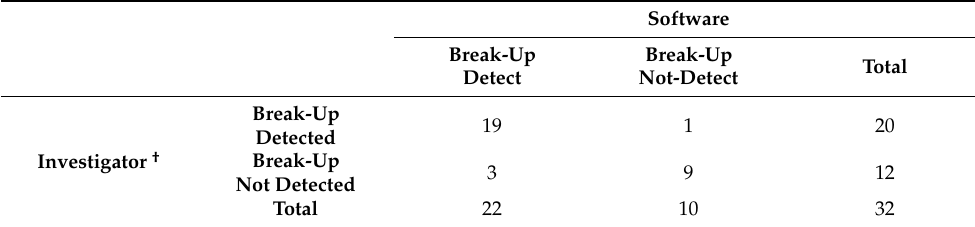
Table 2. Comparison of the sensitivity of NIBUT detection in a subset of subjects *. FBUT < 10 s (32 eyes).